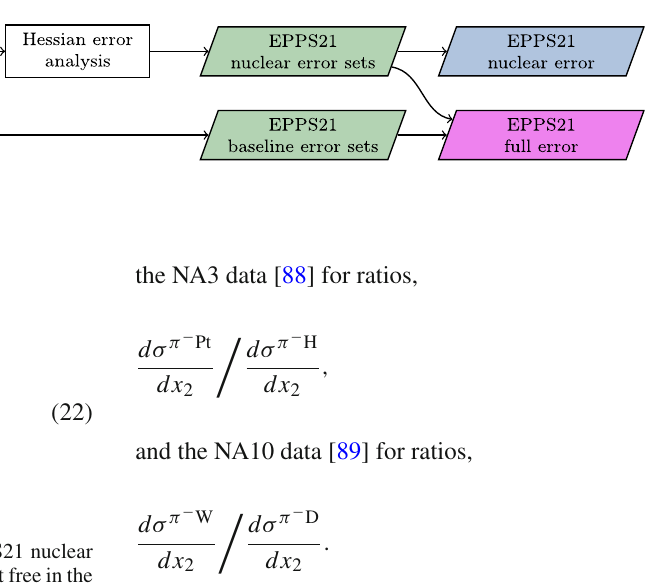
the NA3 data [88] for ratios,